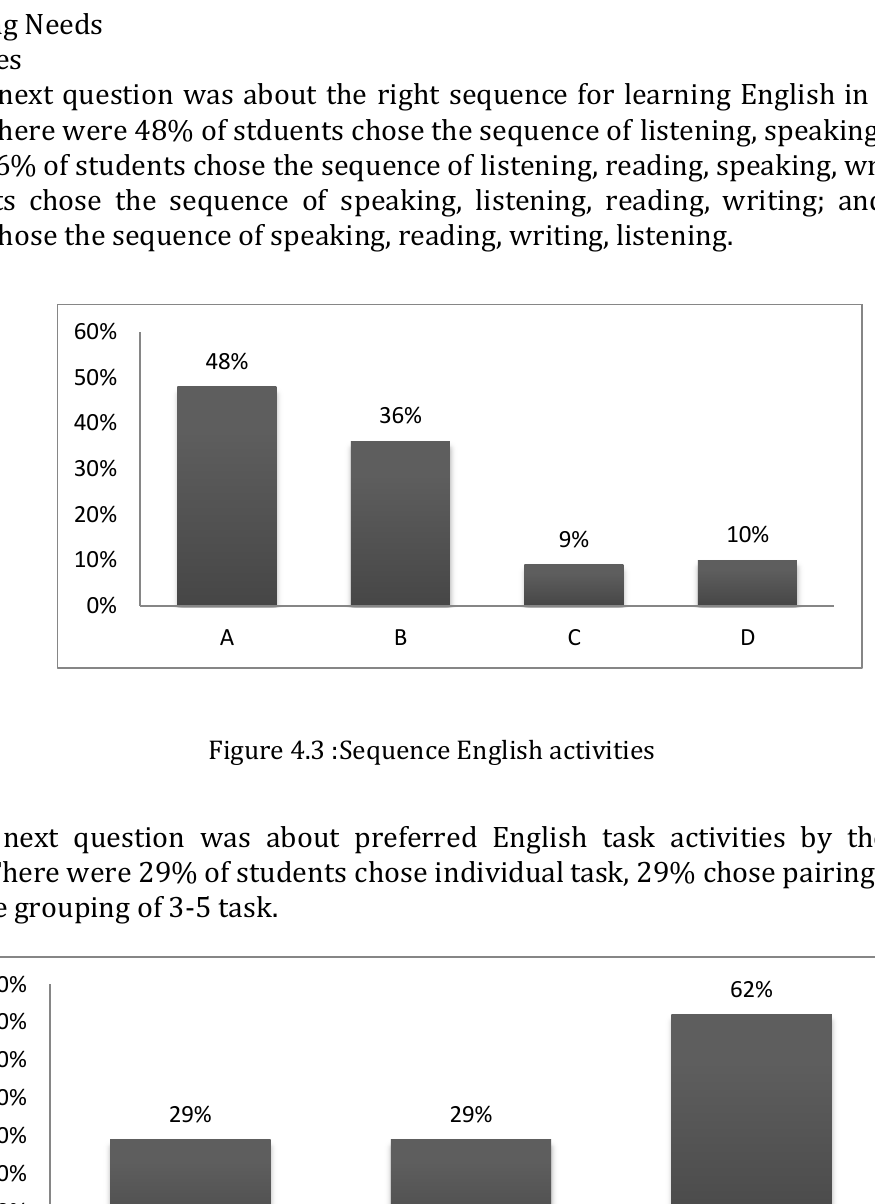
Figure 4.4: Students preferred task